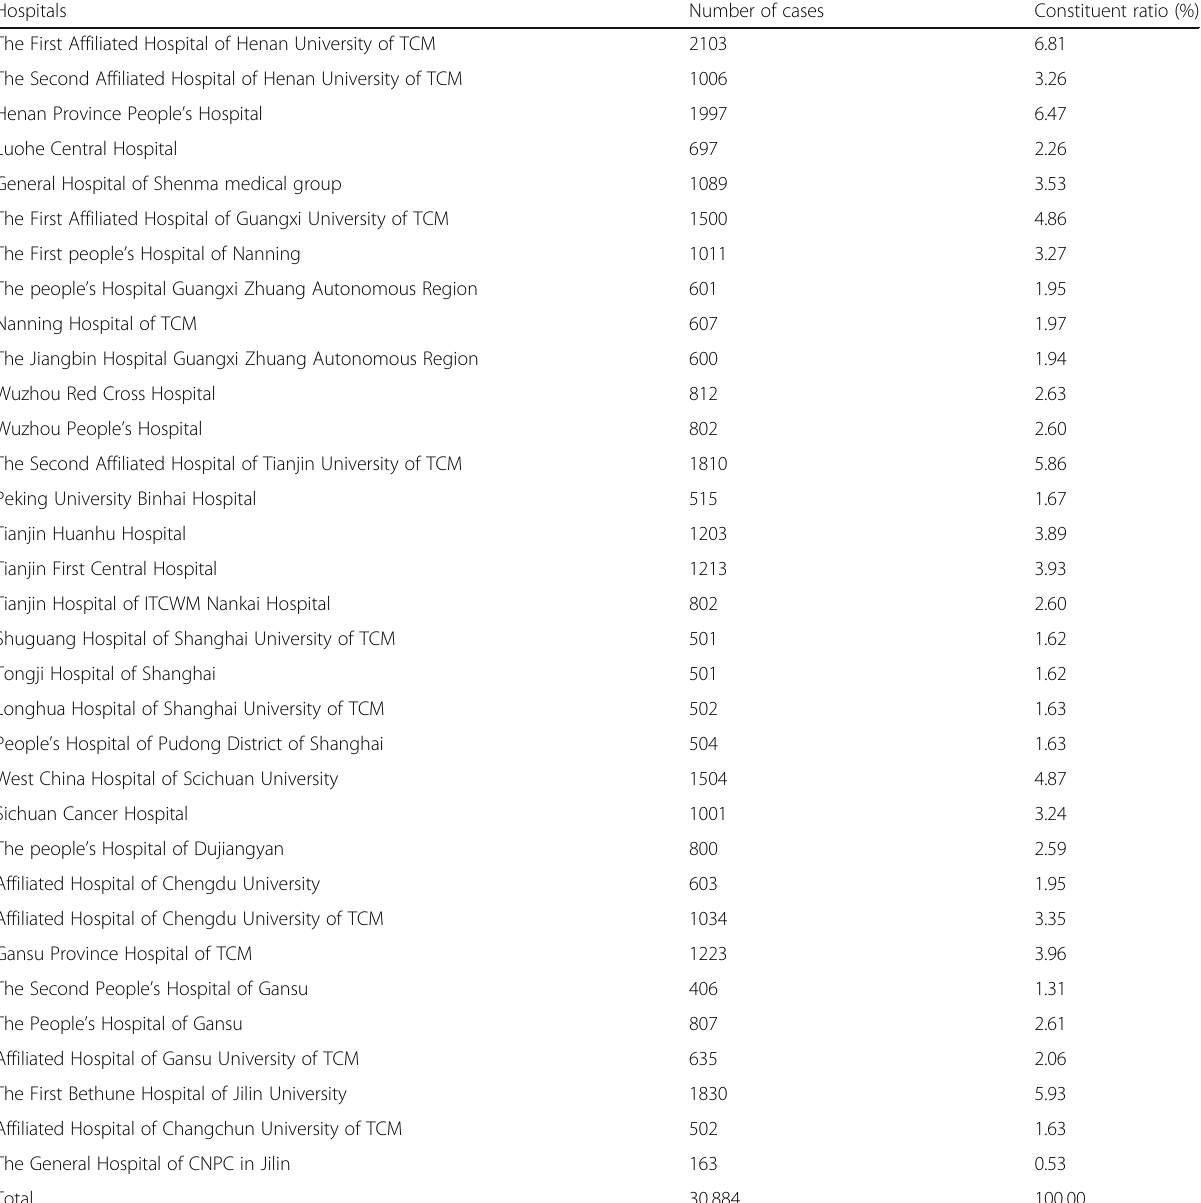
Table 1 The number of ADE cases in 33 monitoring hospitals